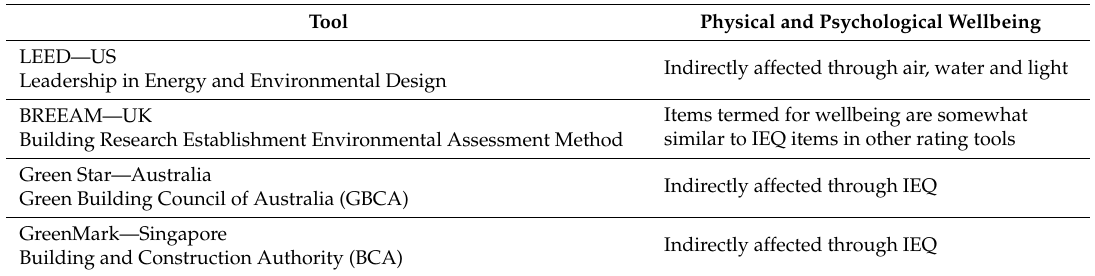
Table 2. Green building rating tools and ways of addressing wellbeing (adapted from Loh, 2016 [47]).